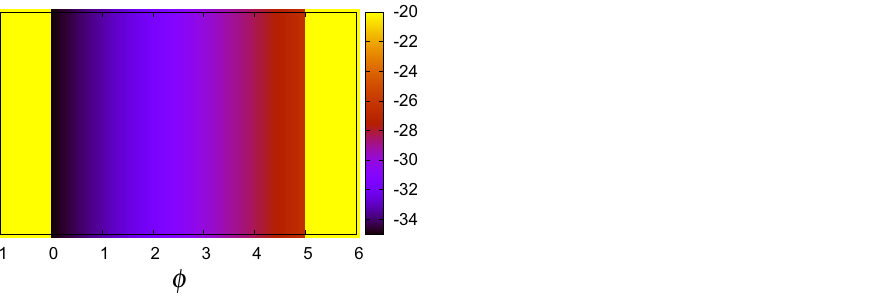
Figure 7. Continuous local energy used for the CPF model at 0 K. Continuous local free energy at 1300 K looks the same, because the potential renormalization correction (cid:31) F ren is very small.